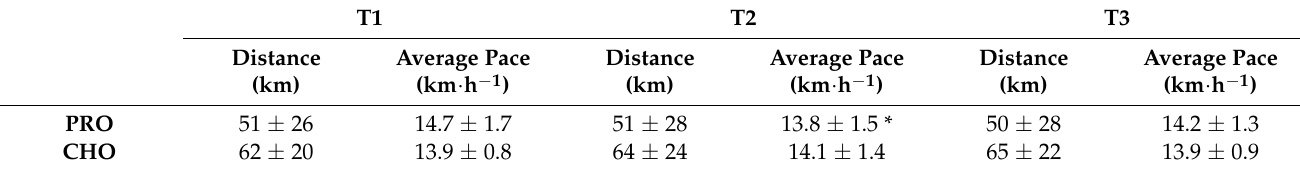
Table 4. Running distance and speed during each week of training throughout the duration of the